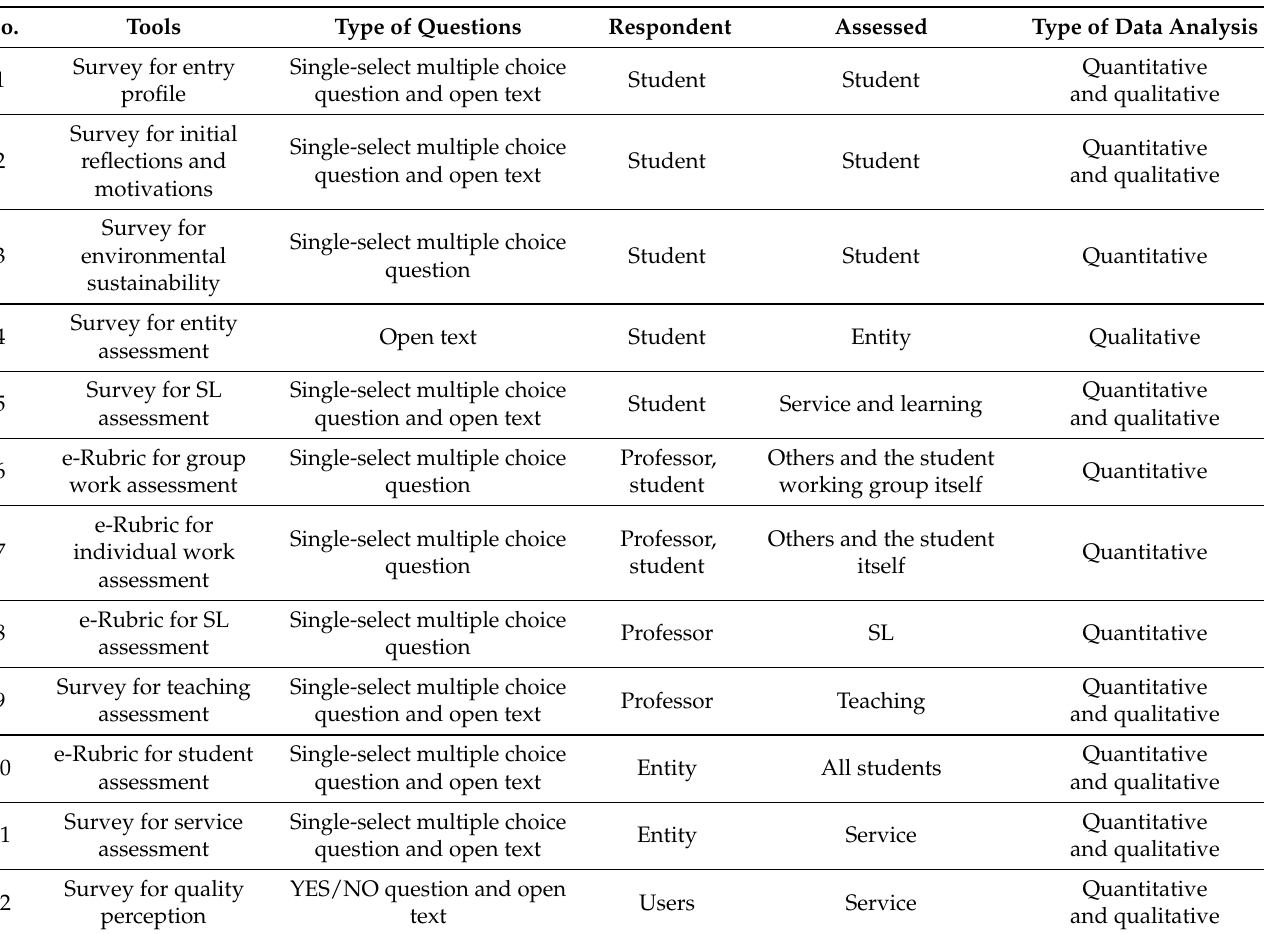
Table 4. Assessment